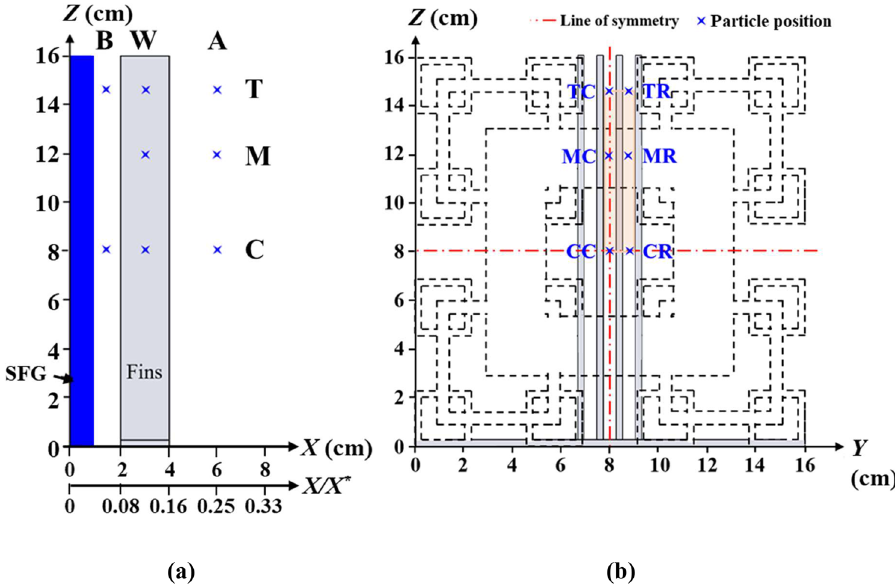
Figure 7. Illustrations of SPTV measured locations (marked by stars) in ( a ) streamwise X – Z plane and ( b ) spanwise Y – Z plane. Note: B is position before fins, W is within fins, A is after fins, and (T, M, C, R) indicate (top, middle, centre, right